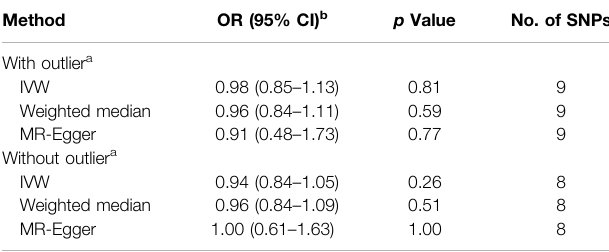
TABLE 2 | MR results for the effect of self-reported moderate-vigorous physical activity on chronic back pain (CBP).